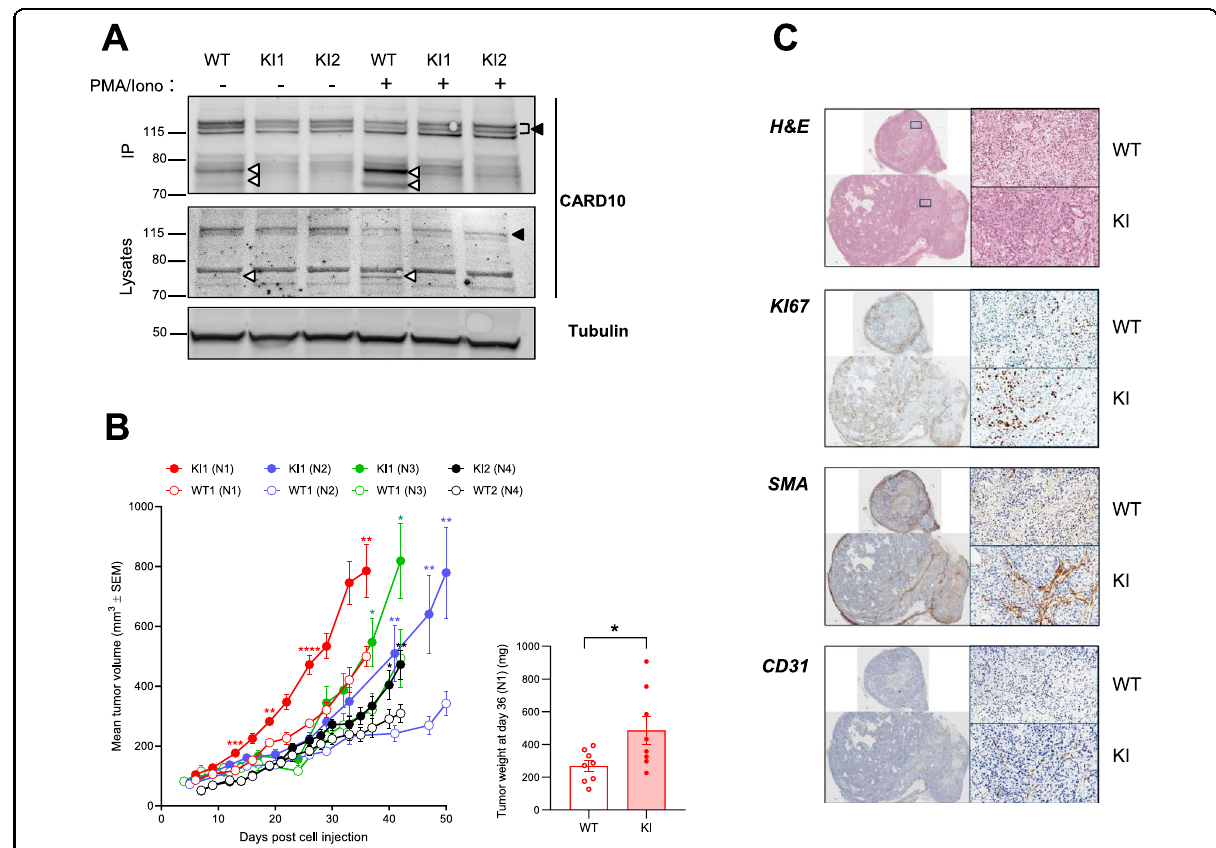
Fig. 3 CARD10 cleavage at R587 controls A549 tumor growth. A A549 cells (parental WT) or A549-KI (two clones containing the CARD10 point mutation R587A introduced by CRISPR) were treated, stimulated and analyzed for CARD10 as in Fig. 2A. Full length CARD10 and the cleaved CARD10 fragment (both as doublet resulting from differential phosphorylation) are indicated with arrowheads ( N = 2). B 2x10E6 A549-WT cells or KI cells were injected into the fl anks of nude mice. Tumor growth was monitored over time and is shown as mean tumor volume (mm 3 ) ± SEM ( n = 8 per group for N1, n = 11 for N2, n = 6 for N3, and n = 8 for N4), which was measured biweekly for 36 – 50 days. The graph shows the data from four experiments performed independently with the two A549-KI clones. At day 36 (N1 experiment), tumors were extracted and weighed (right panel). Data are reported as means ± SEM. Statistical analyses were carried out using GraphPad Prism software. Differences among groups were assessed using one- tailed Student ’ s t tests. P < 0.05 was considered to be statistically signi fi cant. C Histological analysis of the three biggest tumors per group (N2, described in B) was performed and the data for one representative tumor per group are shown. Tumor sections were stained with H&E for general structure, Ki67 for proliferation, smooth muscle actin (SMA) for stromal cell visualization, and msCD31 for endothelial cell content. The scale is indicated at the bottom left of every image (1 mm for full tumors and 100 µm for the 10X magni fi